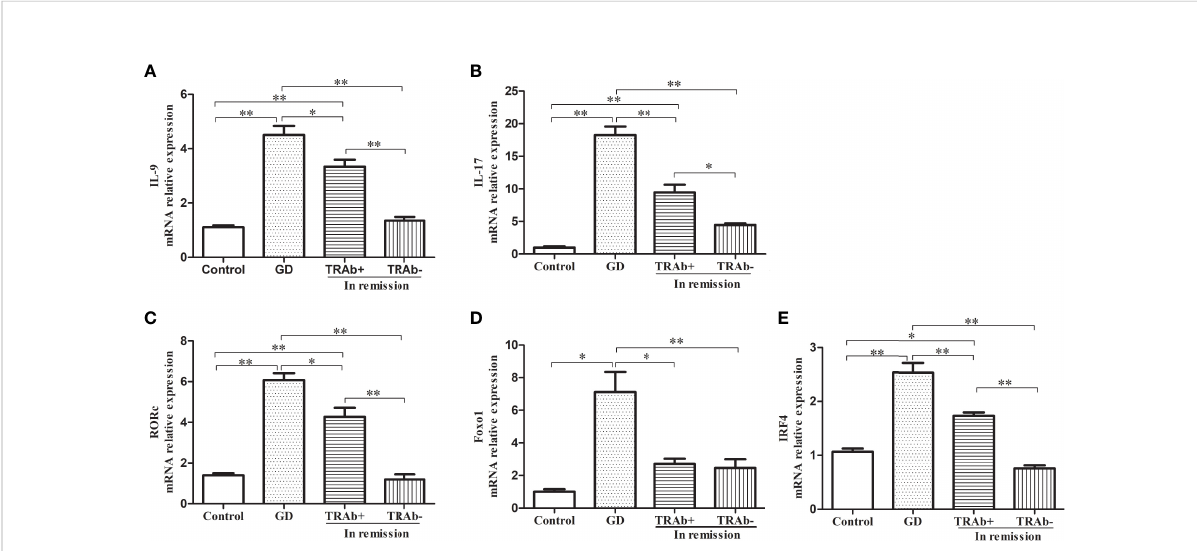
FIGURE 3 Quantitative analysis of the mRNA expression of Th9 and Th17 cell subset-related cytokines and transcription factors in patients with Graves ’ disease (GD) in different stages and controls were obtained using RT-PCR. Relative mRNA expression of IL-9, IL-17, RORc, Foxo1, and IRF-4 in each group are represented by (A – E) , respectively. * P < 0.05, ** P < 0.01. TRAb, thyroid-stimulating hormone receptor